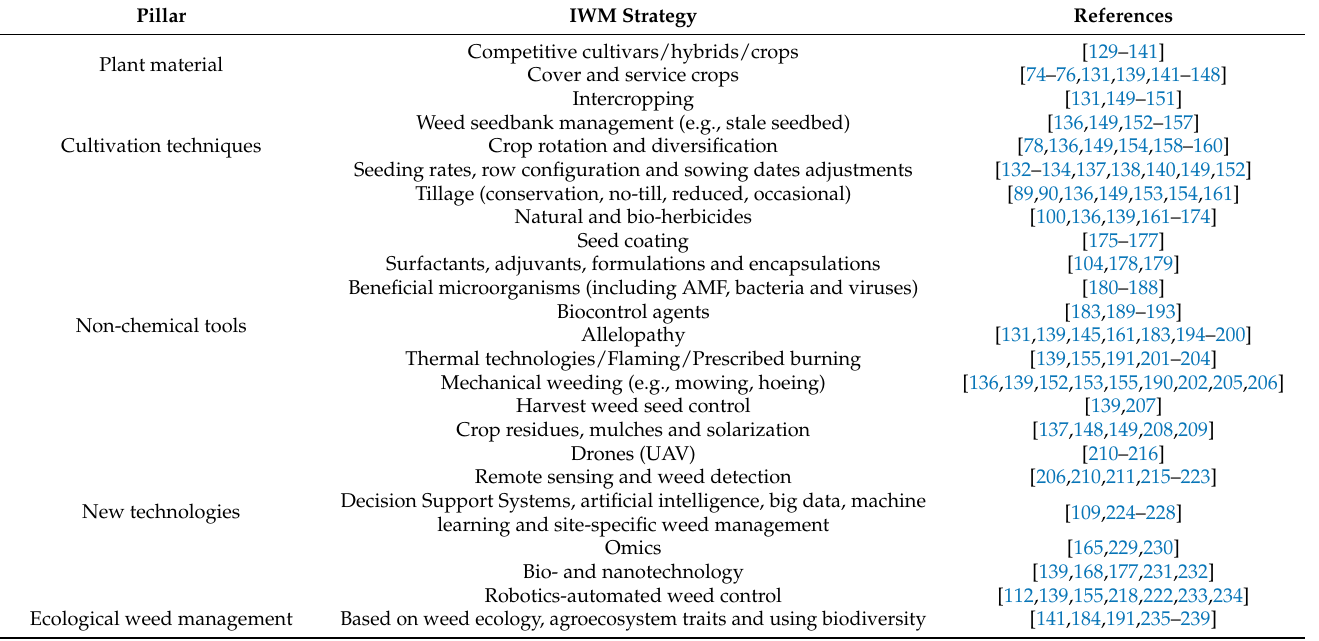
Table 2. Overview of reviews on integrated weed-management